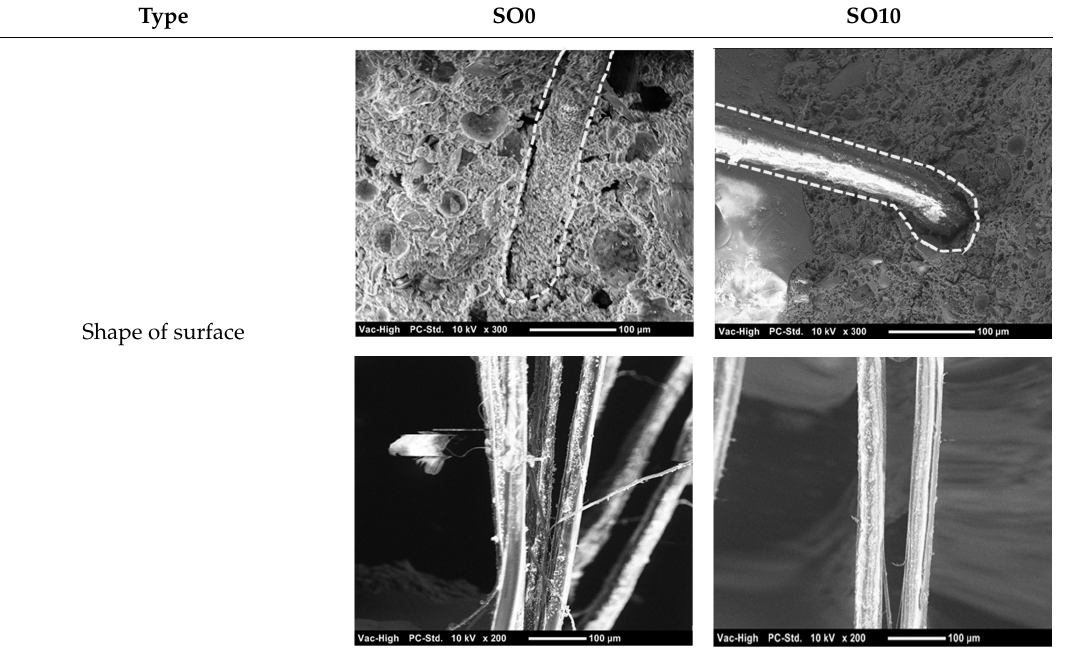
Table 4. Scanning electron microscope observation.